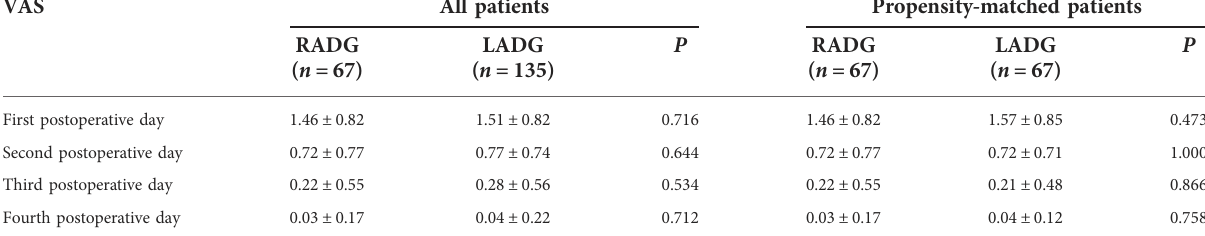
TABLE 4 Postoperative VAS between the RADG and LADG groups. VAS All patients